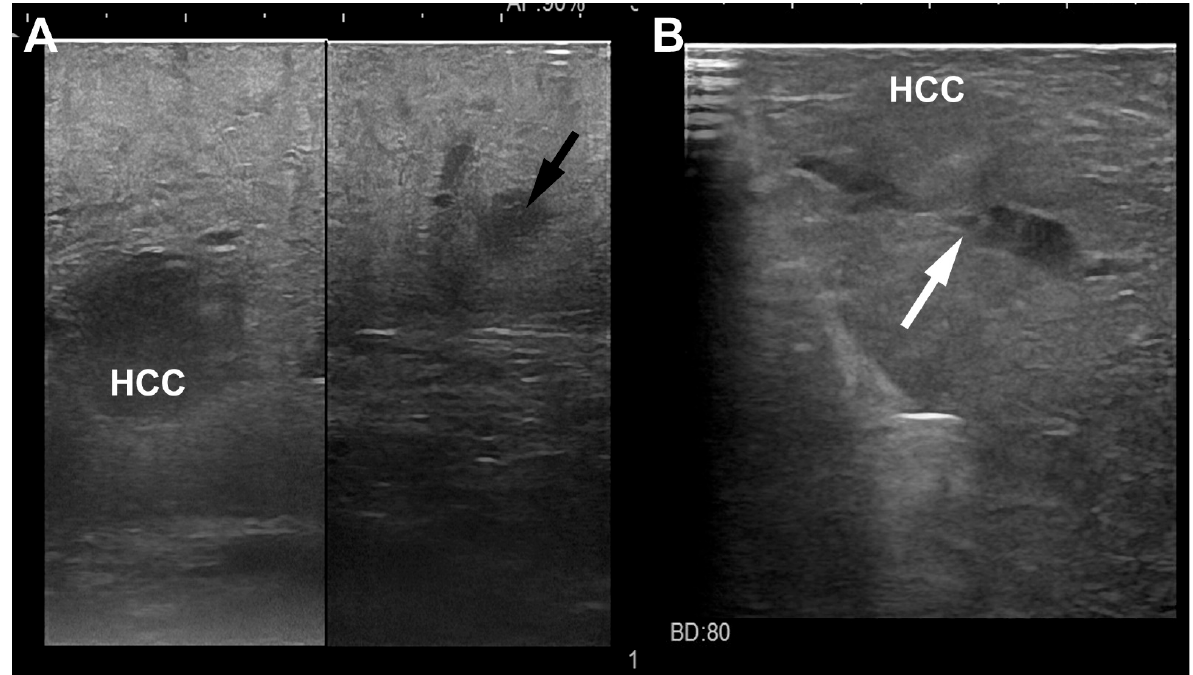
Figure 6. Laparoscopic ultrasound images of a HCC nodule ( A ) located in the sixth segment with a satellite (black arrow) at distance; another HCC nodule ( B ) located in the fifth segment with vascular microin fi ltration (white arrow).